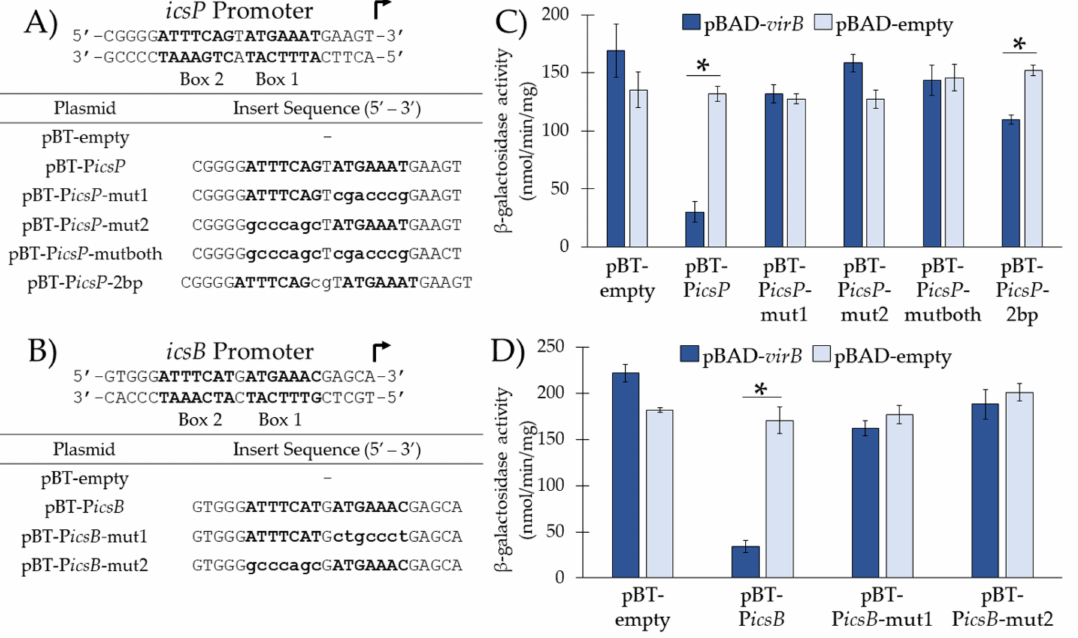
Figure 2. Investigation of sequences required and sufficient for VirB-binding in vivo from the icsP and icsB promoters. ( A , B ) DNA sequences inserted into pBT-empty. Uppercase nucleotides refer to native sequences; lowercase nucleotides refer to mutated sequences. Box 1 and Box 2 are in bold. ( C,D ) P